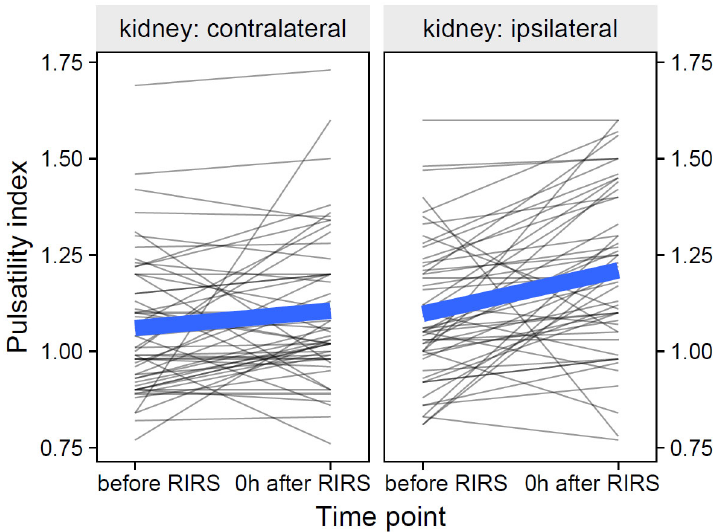
Figure 5. The effect of kidney side on the pulsatility index over time (the thin, semitransparent black lines in the background are the individual-level data. The bold blue lines in the foreground are the group averages). The figure shows that the effects of the kidney side on the focal variable of the pulsatility index were quite different over time. The inclusion of the effects of mean stone volume, energy used, pre-stenting, and kidney side at separate time points is presented in Sections 3.1.2.1–3.1.2.3.